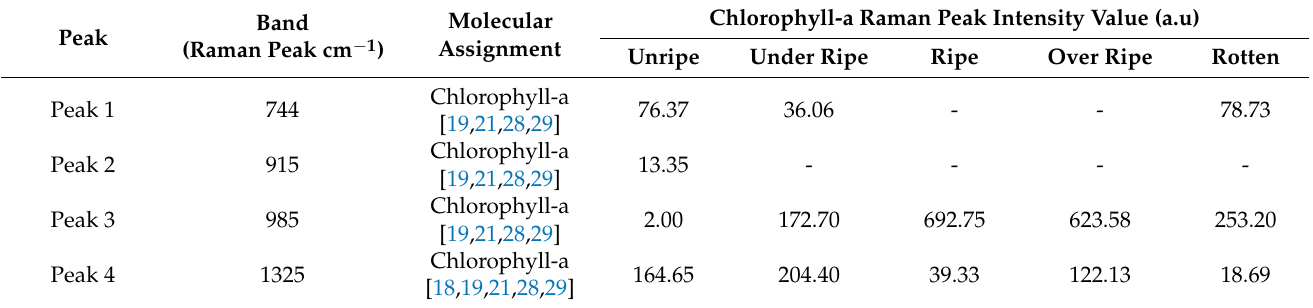
Table 2. Summary of Raman bands and their molecular assignments with intensity values for five oil palm fruit ripening classes for sample A without spectrum pre-processing.